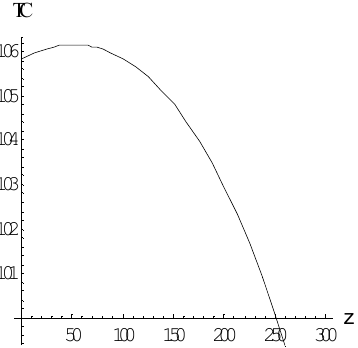
Fig.6.(a) The effect of parameter ζ on the total cost in the crisp model